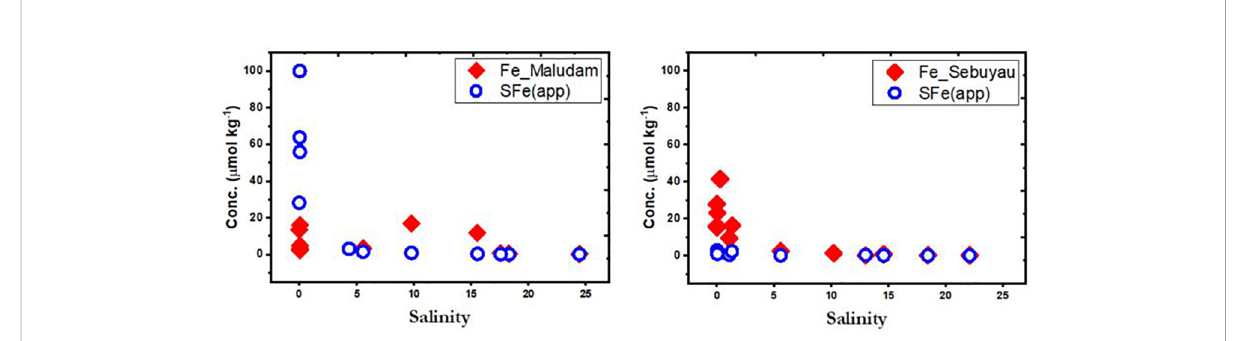
FIGURE 9 Plots showing Fe concentration and modelled output of Apparent Fe Solubility (SFe(app)) as a function of salinity in Maludam and Sebuyau